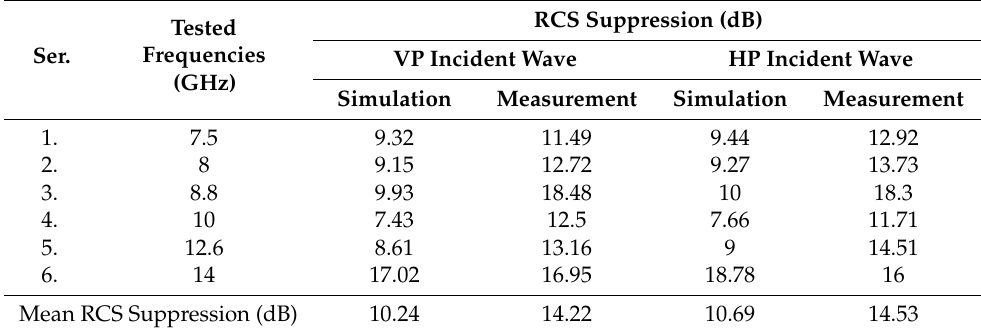
Table 2. RCS suppression values at tested